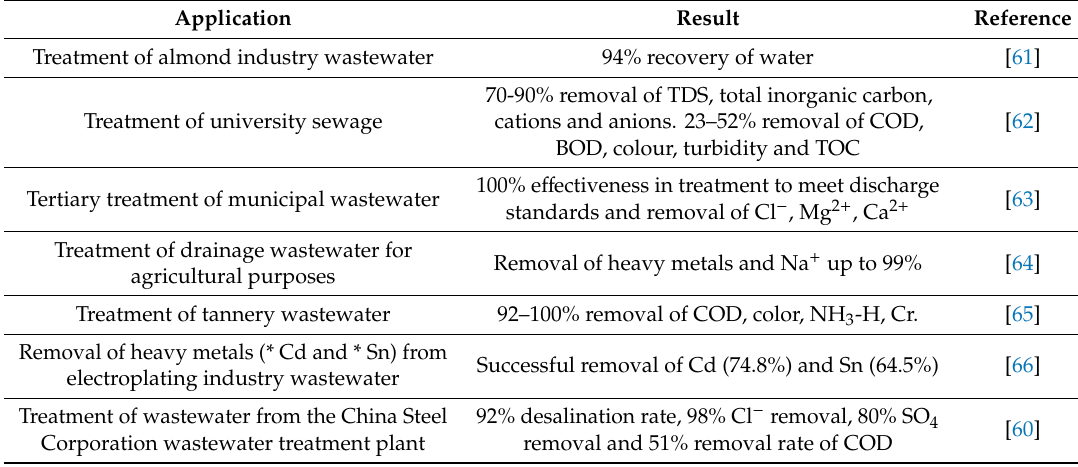
Table 4. Application of ED and EDR in wastewater treatment.